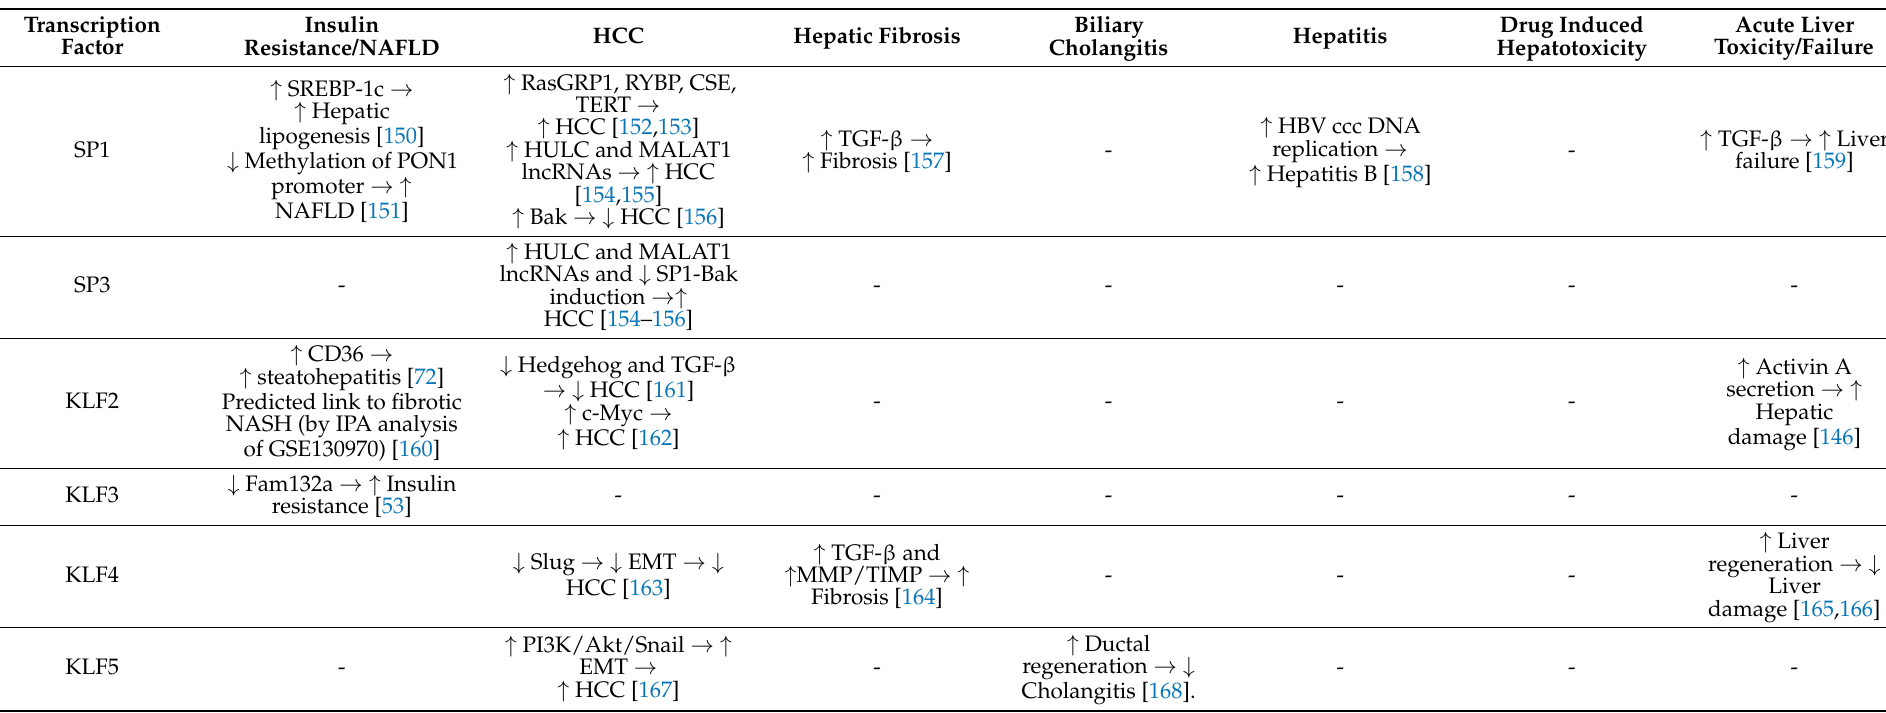
Table 1. Summary list of the roles of SP/KLF transcription factors in various hepatic diseases. (Abbreviations: CCL4: Carbon tetrachloride, CSE: Cystathionine gamma-lyase, EMT: Epithelial-mesenchymal transition, HCC: hepatocellular carcinoma, HFD: High-fat diet, HSC: Hepatic stellate cells, HULC: Highly upregulated in liver cancer, MALAT1: Metastasis Associated Lung Adenocarcinoma Transcript 1, MMP-9: Matrix metalloproteinase 9, NAFLD: Non-alcoholic fatty liver disease, NR0B2: Nuclear receptor subfamily 0, group B, member 2, PCNA: Proliferating cell nuclear antigen, PGC-1 α : Peroxisome proliferator-activated receptor-gamma coactivator (PGC)-1alpha, PON1: Paraoxonase-1, PPAR α : Peroxisome proliferator-activated receptor α , Ras GRP1: RAS guanyl-releasing protein 1, RYBP: RING1 and YY1-binding protein, SREBP-1c: Sterol regulatory element binding protein-1c, TERT: Telomerase reverse transcriptase, TGF- β : Transforming growth factor β , Twist2: Twist Family BHLH Transcription Factor 2, zDHHC7: Zinc finger DHHC-type palmitoyltransferase 7). Arrow symbol ↑ denotes increase, ↓ —decrease and → —connection between two